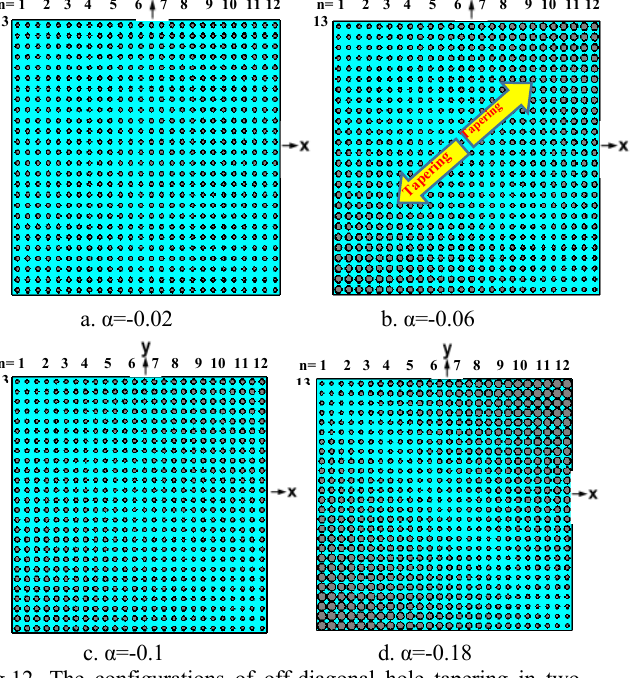
Fig.12. The configurations of off-diagonal hole tapering in two directions with different α, R o = 1.5 mm, n =1, 2…, 13 and ζ =1.